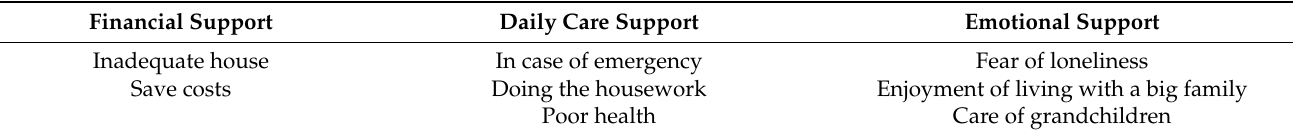
Table 3. Intergenerational factors in household cohabitation.